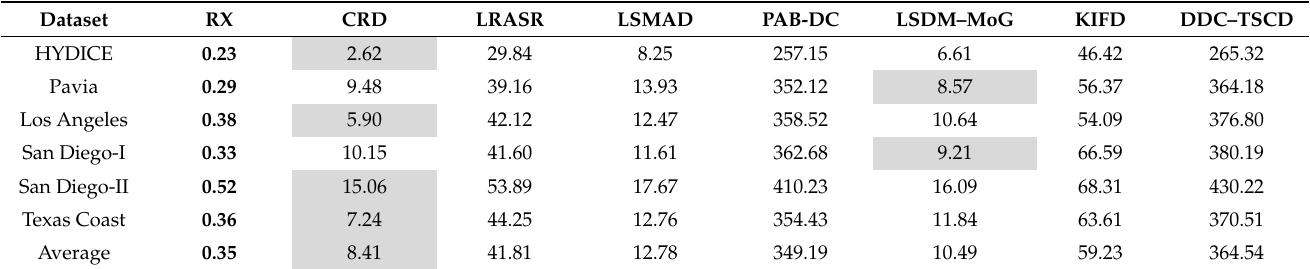
Table 4. Computing time (in seconds) on different methods over five